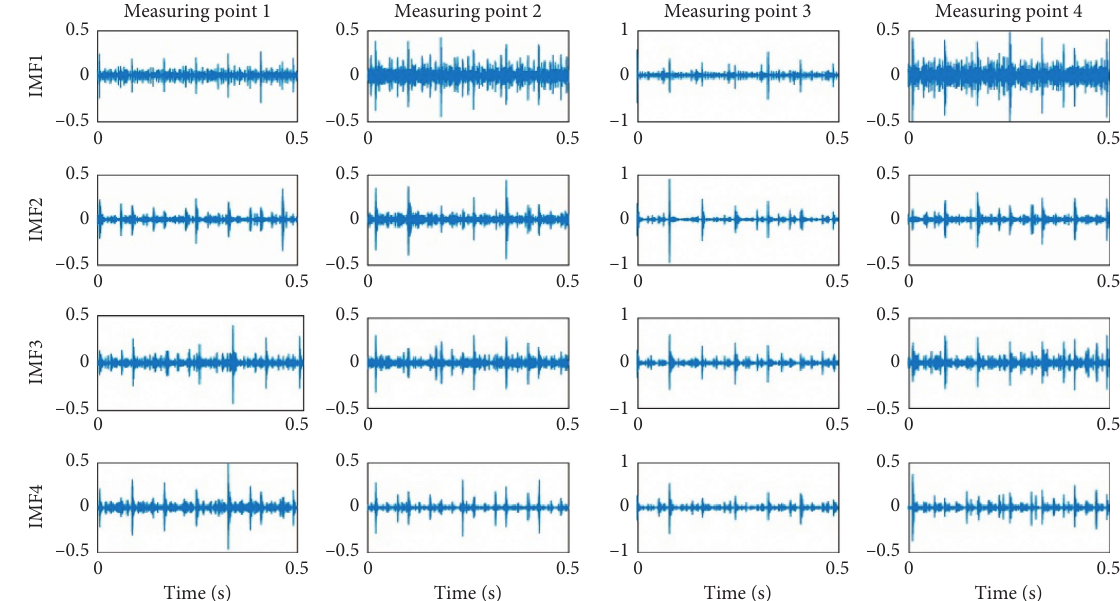
Figure 13: Decomposition result of original signals by MVMD under normal state.